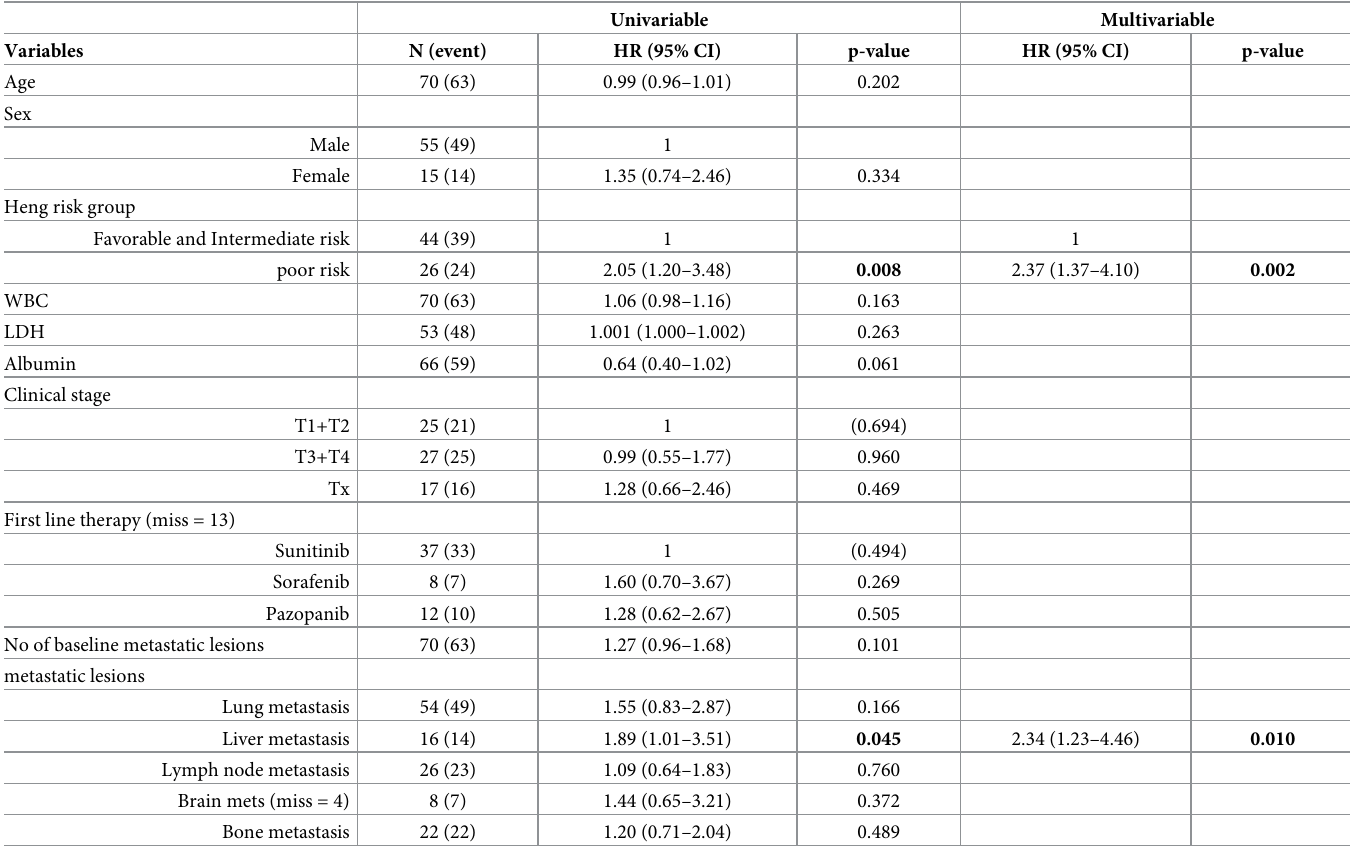
Table 2. Cox regression analysis of the prognostic factors for progression-free